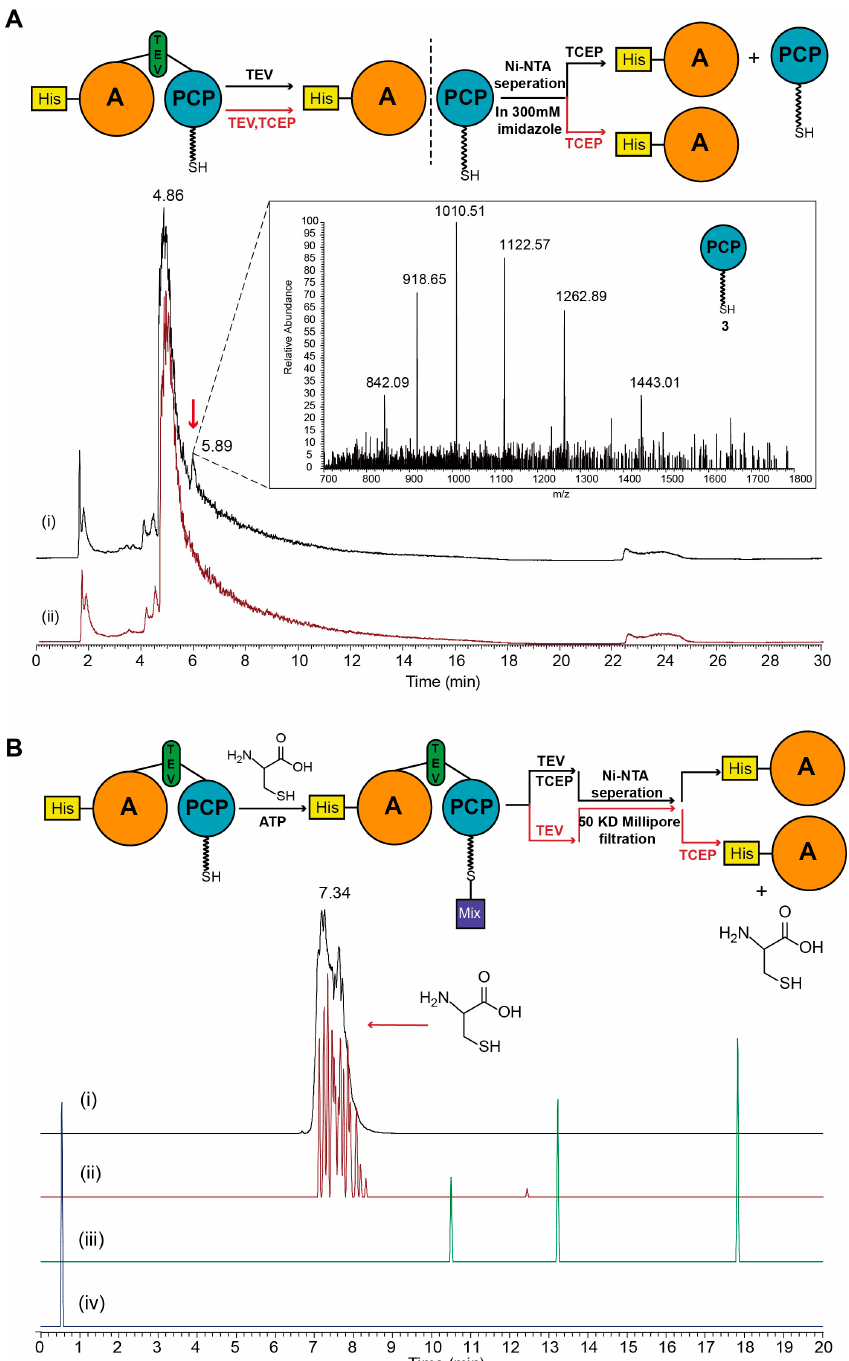
Figure 5. Experiments to discuss the function of A domain. ( A ) The description of incubation reactions without cysteine. (i) TIC of the assay in which TCEP was added before detection. (ii) TIC of the assay in which TCEP was added at the same time as TEV. The peak at 5.89 min was identified as compound 3 . ( B ) The description of incubation reactions which were set out to verify the additional function of A domain. (i) MW extraction for exact MW of cysteine from TIC of a standard sample of cysteine. (ii) MW extraction for exact MW of cysteine from TIC of the assay to which TCEP was added before detection. (iii) MW extraction for exact MW of cysteine from TIC of the assay in which TCEP was added before Ni-NTA separation. (iv) MW extraction for exact MW of cysteine from TIC of the assay in which mutated protein DtpB-APCP-C168A was used and TCEP was added before